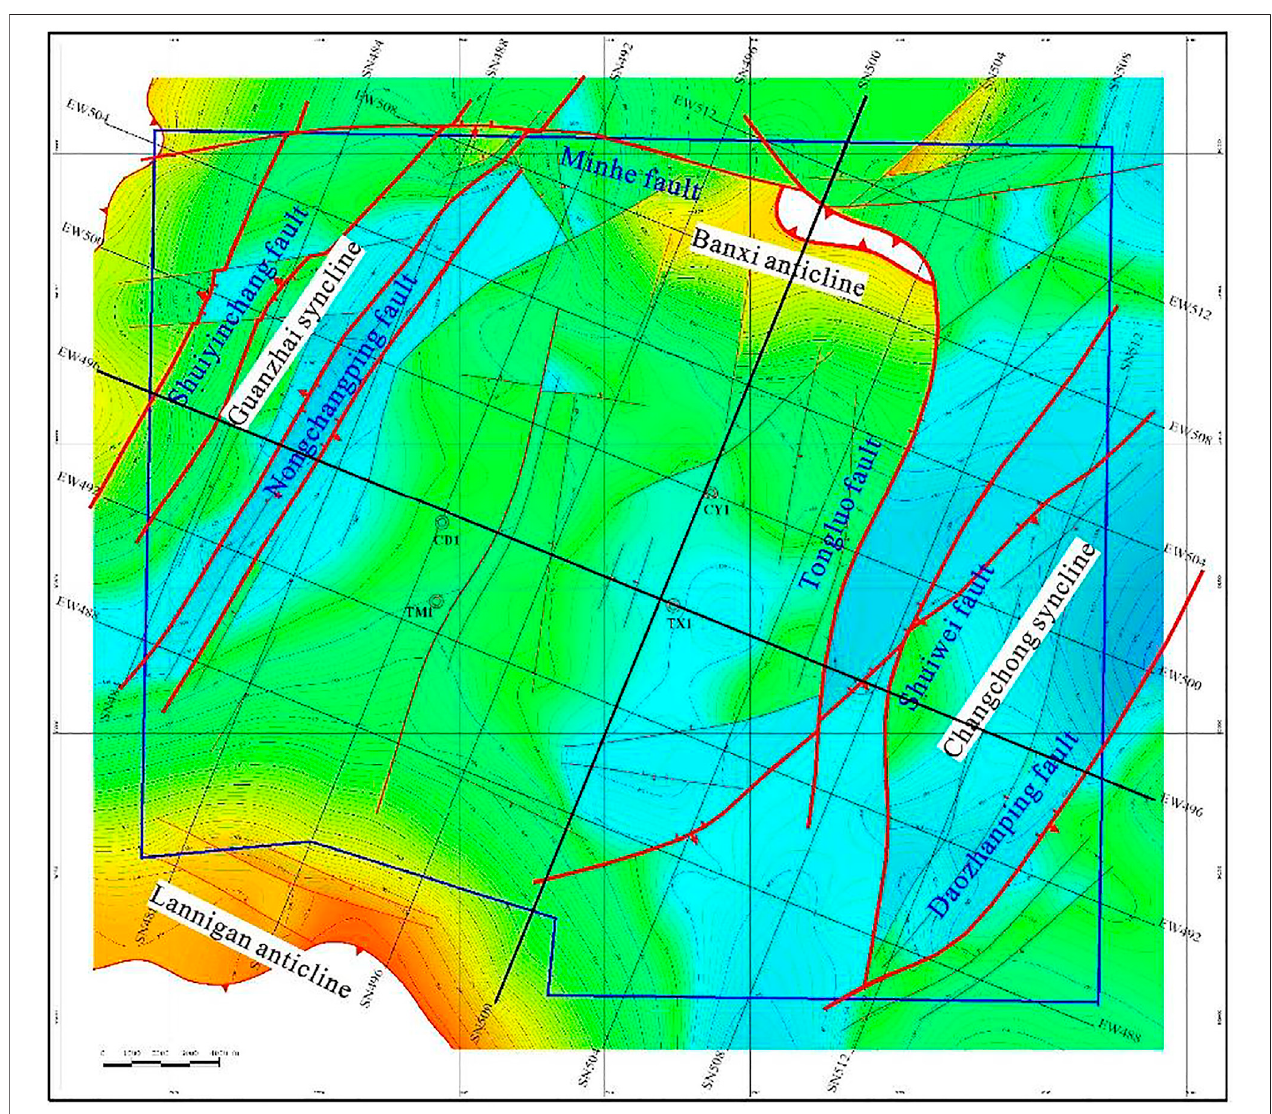
FIGURE 4 | Geological structure and faults map of Niutitang shale in Cen ’ gong